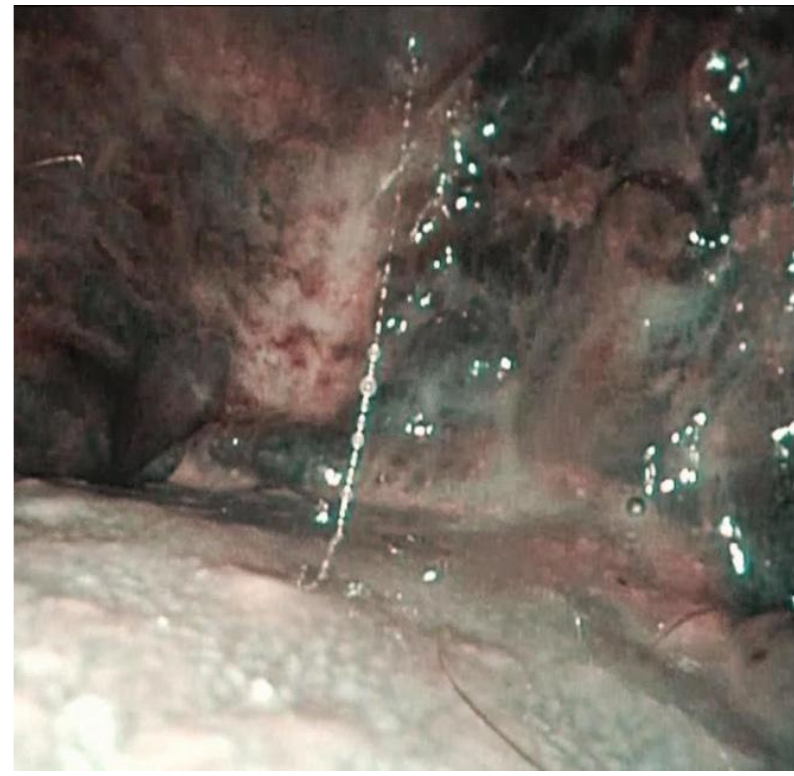
Figure 6. Intrapapillary capillary loop enhanced with narrow band imaging.